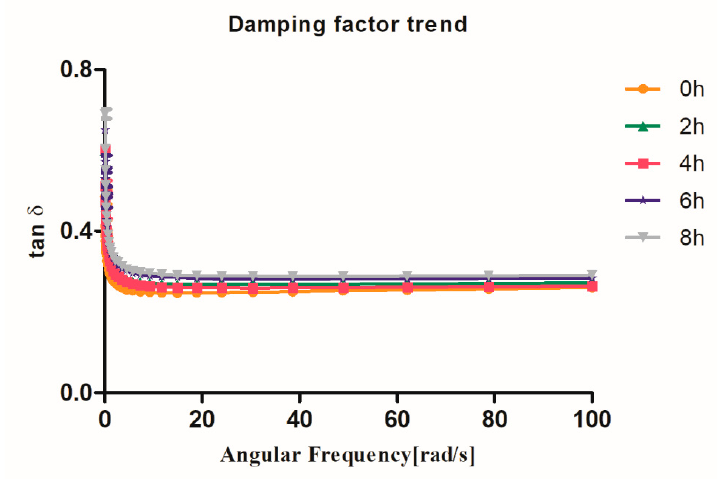
Figure 4. Damping factor trends obtained through the rheology assay in fermented doughs.